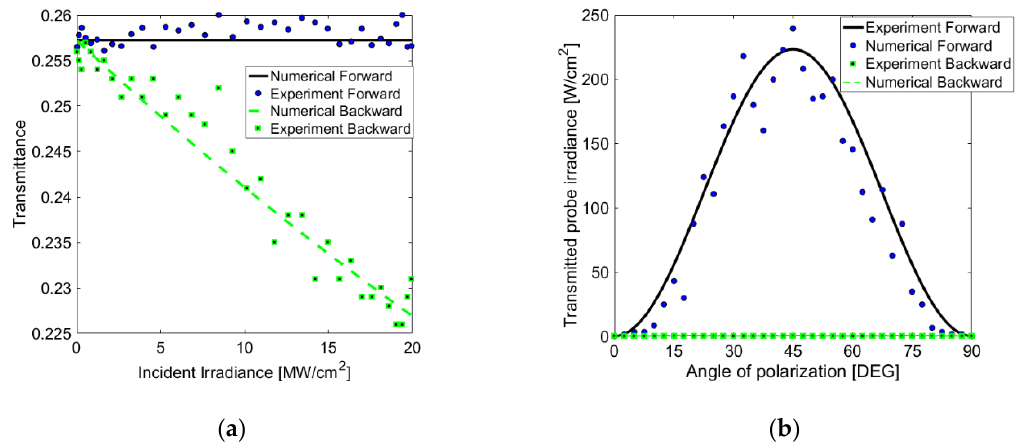
Figure 7. ( a ) Single-beam transmittance as a function of the incident irradiance; ( b ) transmitted probe irradiance as a function of the angle between planes of polarization of the incident beams. Table 2. Nonlinear optical parameters evaluated in the samples studied at 532 nm and 4 ns pulses. Sample